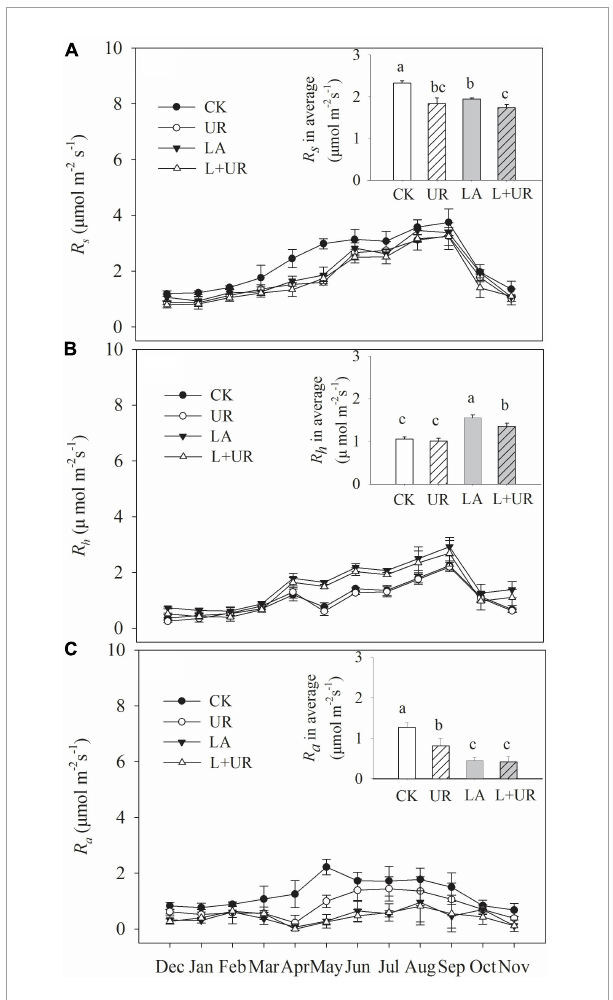
FIGURE1 Variations of R s (A) , R h (B) , and R a (C) under different treatments from December 2011 to November 2012. The inserted figure indicate the annual average of soil respiration ( R s , R h , and R a ) under different treatments. Different lowercase letters among treatments indicate significant difference ( P ≤ 0.05). Values are means with standard errors, n = 3. Control (CK), understory removal (UR),